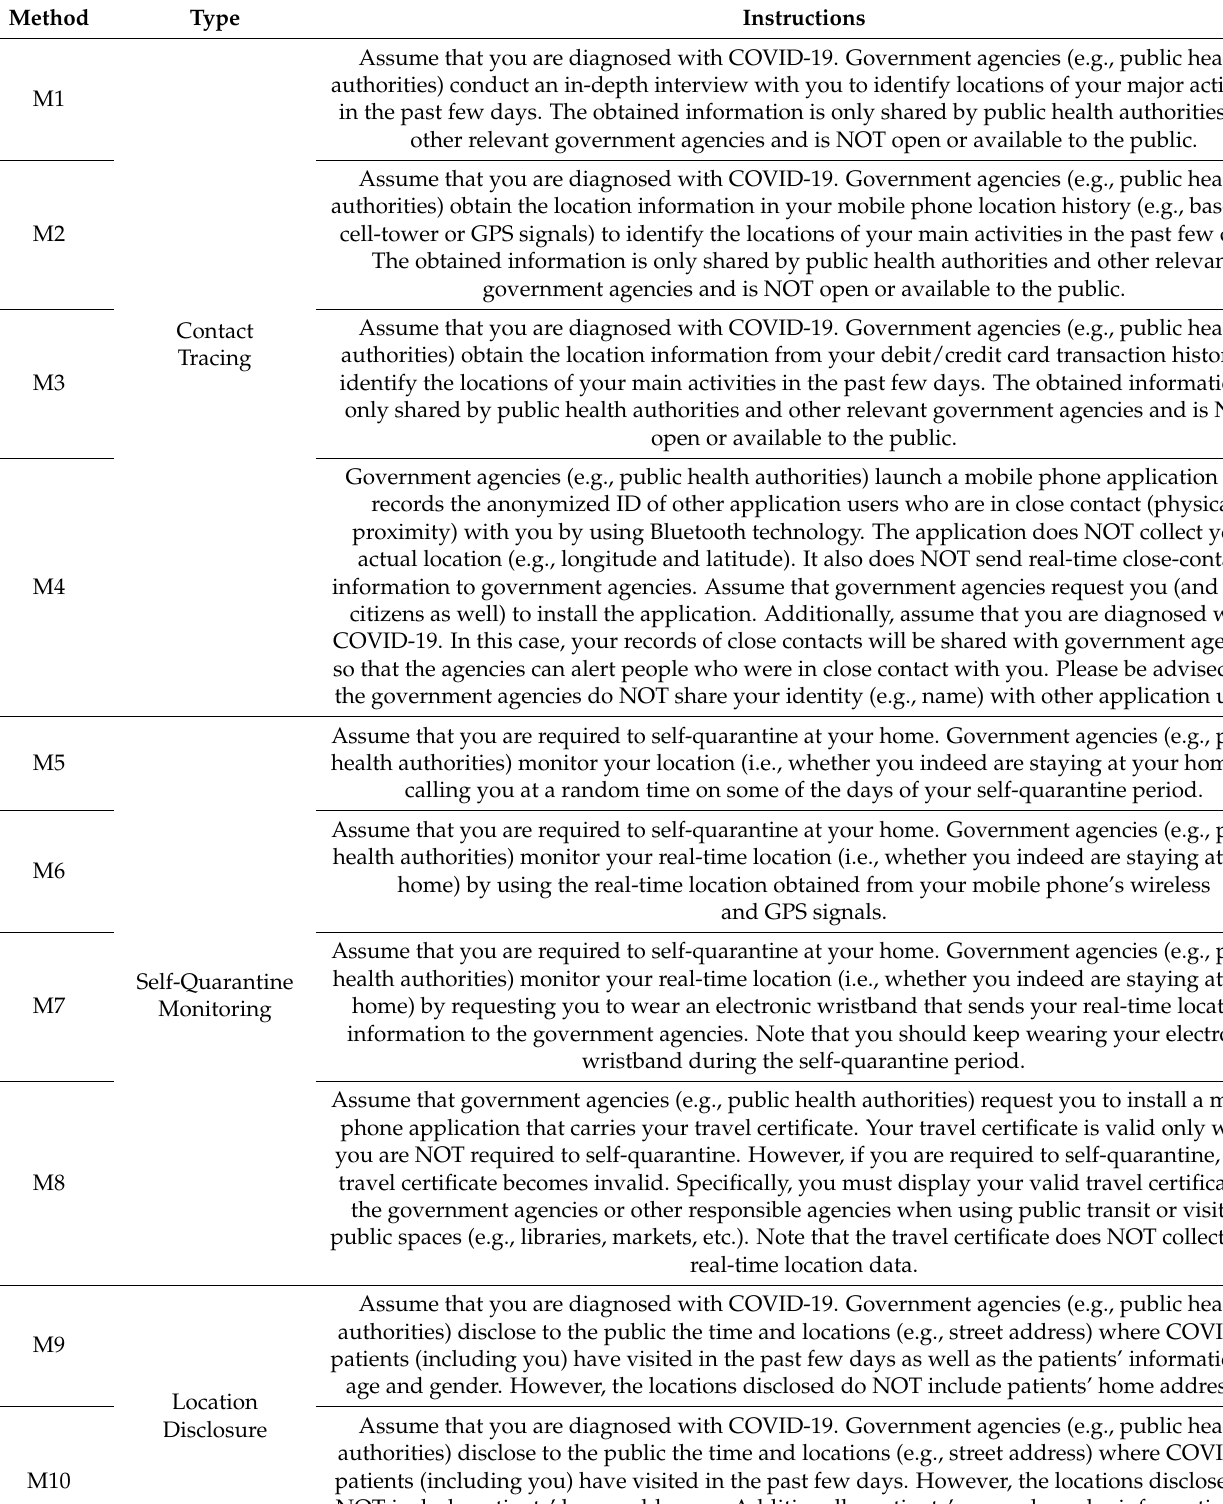
Table A1. Detailed instructions of the 10 methods used in the